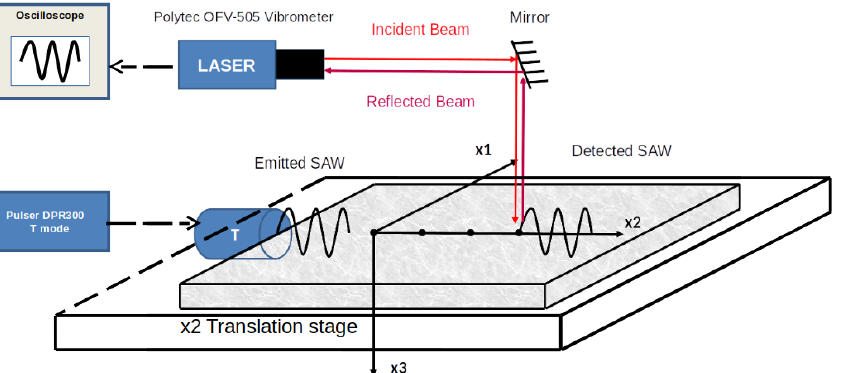
Figure 1. Rayleigh wave detection and monitoring using laser vibrometry, as performed in [1]. Firstly, a vertically polarized shear contact transducer is used to generate a surface wave. Secondly, optical detection is made by using an incident laser beam at the surface of interest and extraction of the wave signal from the Doppler shift of the reflected laser beam frequency due to the motion of the